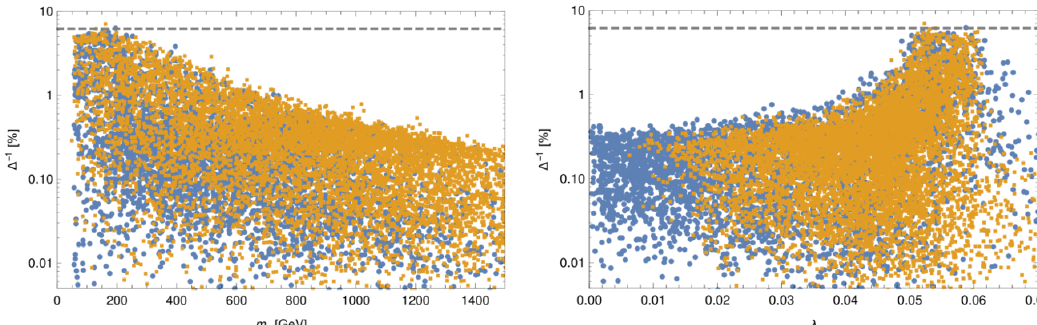
Figure 3 . Fine-tuning of the two-layer model, shown versus the DM mass (left panel) and versus the portal coupling (right panel). For orange (blue) points, the lightest fermionic resonance is heavier (lighter) than the approximate LHC lower bound of 1 TeV. The scale f is (cid:12)xed to 1 : 4 TeV.